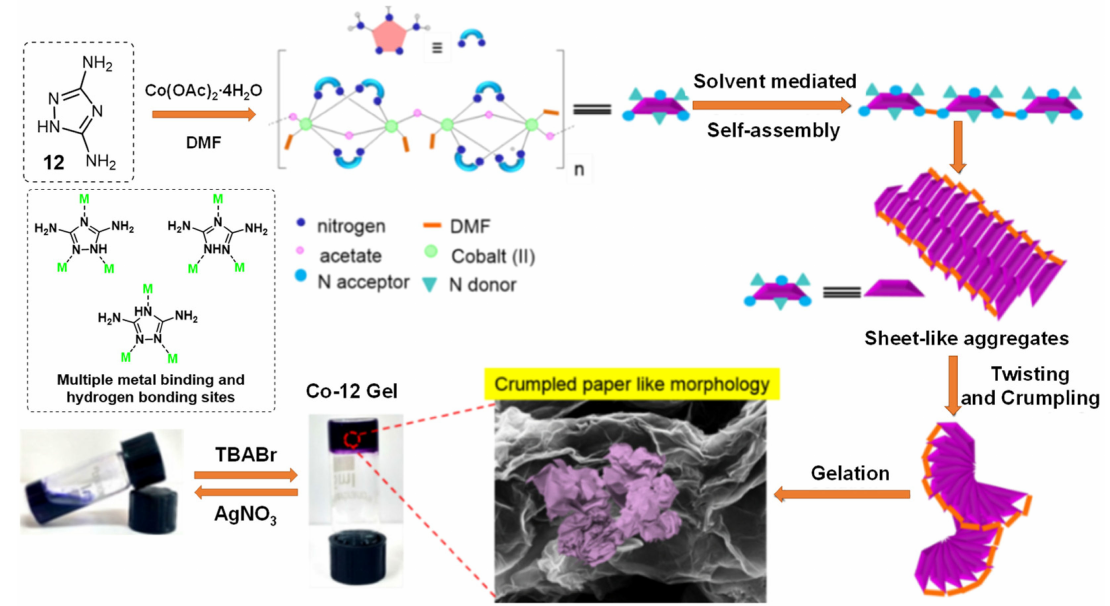
Figure 3. Schematic representation of the probable basic unit of Co-12 Gel, and the gelation mecha- nism and its reversible gel–sol transformation towards Br − . Reprinted with permission from Ref. [39]. Copyright (2019), American Chemical Society.